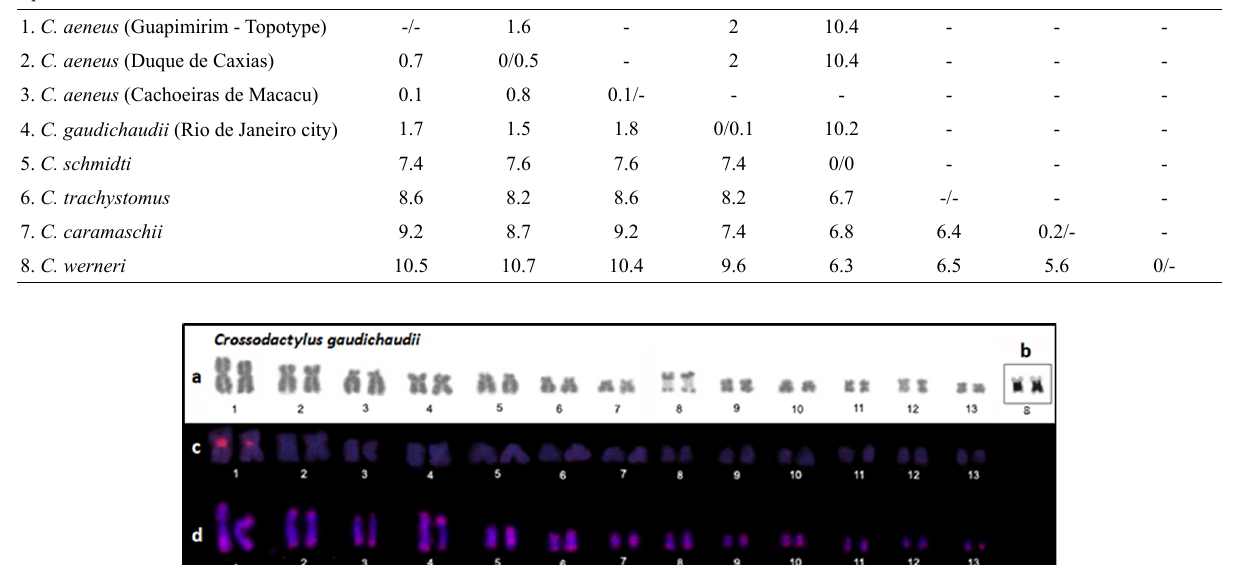
Table 1 – Uncorrected p-distances (in percentage) based on partial 16S rDNA (bottom triangle) and H1 mitochondrial DNA (top triangle) of the Crossodactylus species analyzed in the present study. Gray cells show intraspecific variation of the partial 16S rDNA (left) and H1 mitochondrial DNA (right). Species